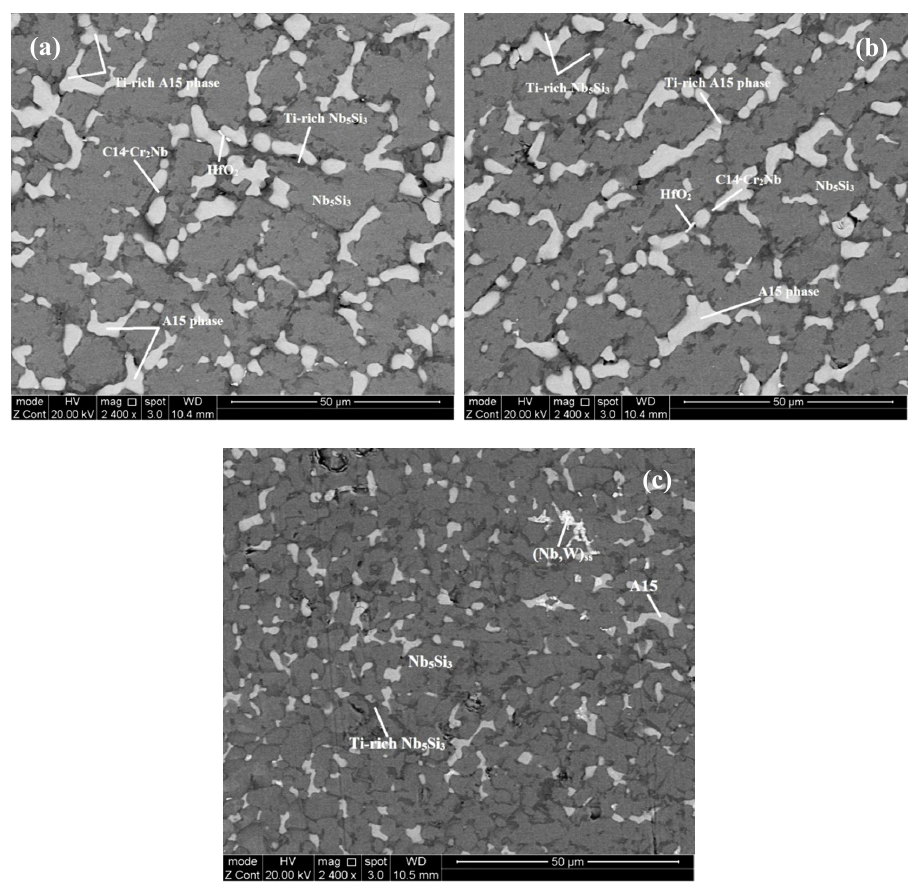
Figure 5. BSE images of the microstructure of the alloy [JZ3+]-AC in the ( a ) top, ( b ) bulk and ( c ) bottom.